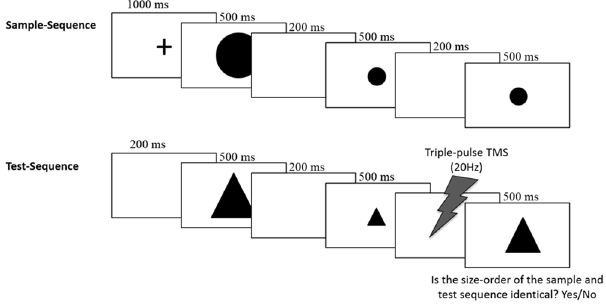
Figure 1. The timeline of an experimental trial in new sequence condition of Experiment 1. Participants were required to indicate whether stimuli of the test and sample sequences followed the same size-order. In the example shown here this was not the case, with the test sequence violating the predictable order. TMS was delivered 150 ms before the onset of the last item of the test